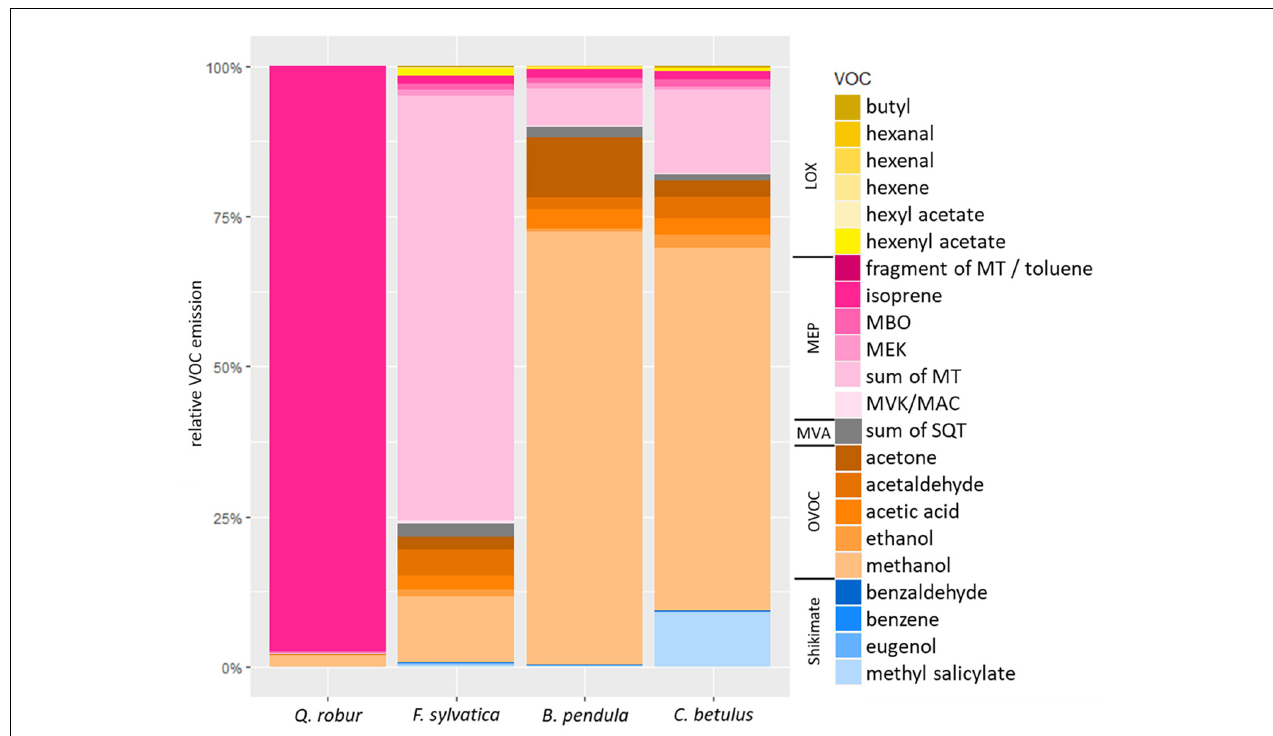
FIGURE 2 | Relative constitutive VOC emission rates (%) of Q. robur, F. sylvatica, B. pendula , and C. betulus seedlings. VOCs are color-coded as being related to LOX- (yellow), MEP- (magenta), MVA- (gray), and Shikimate (blue) pathways or being oxygenated VOCs (OVOCs; orange). MBO, 2-methyl-3-buten-2-ol; MVK, methyl vinyl ketone; MAC, methacrolein; MEK, methyl ethyl ketone; MT, monoterpenes; SQT, sesquiterpenes. See Table 1 for VOC emission